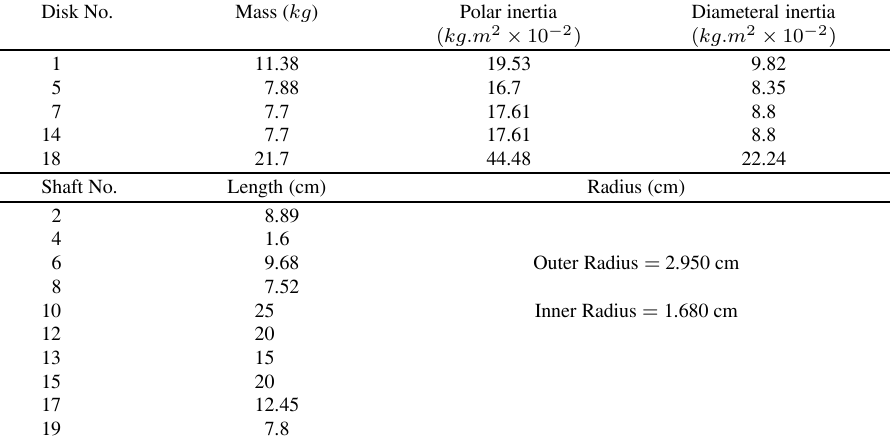
Table 2 Material and geometric parameters of illustrated